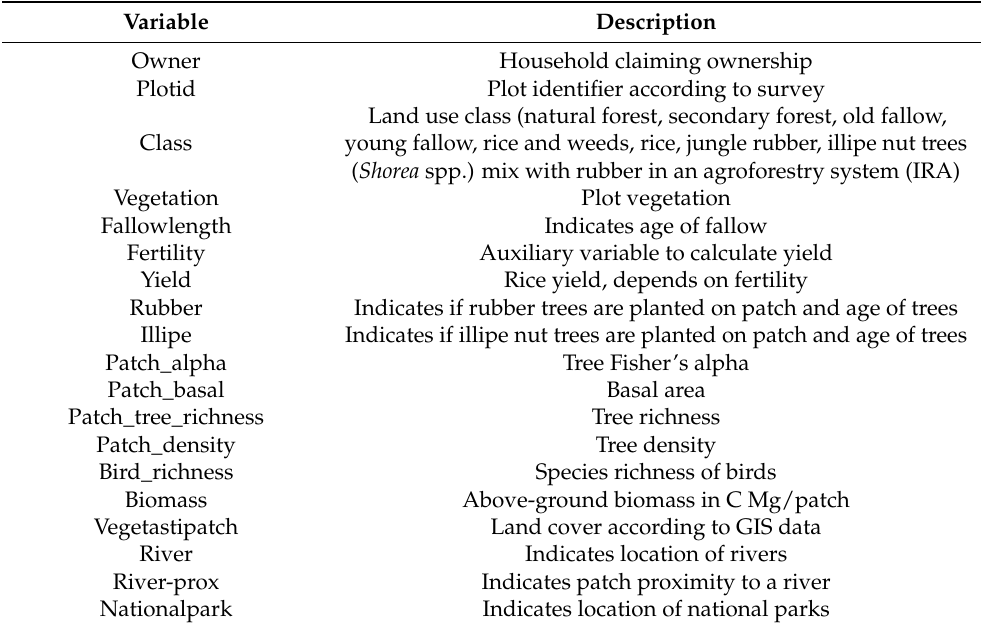
Table 2. Model description: landscape agent variables.